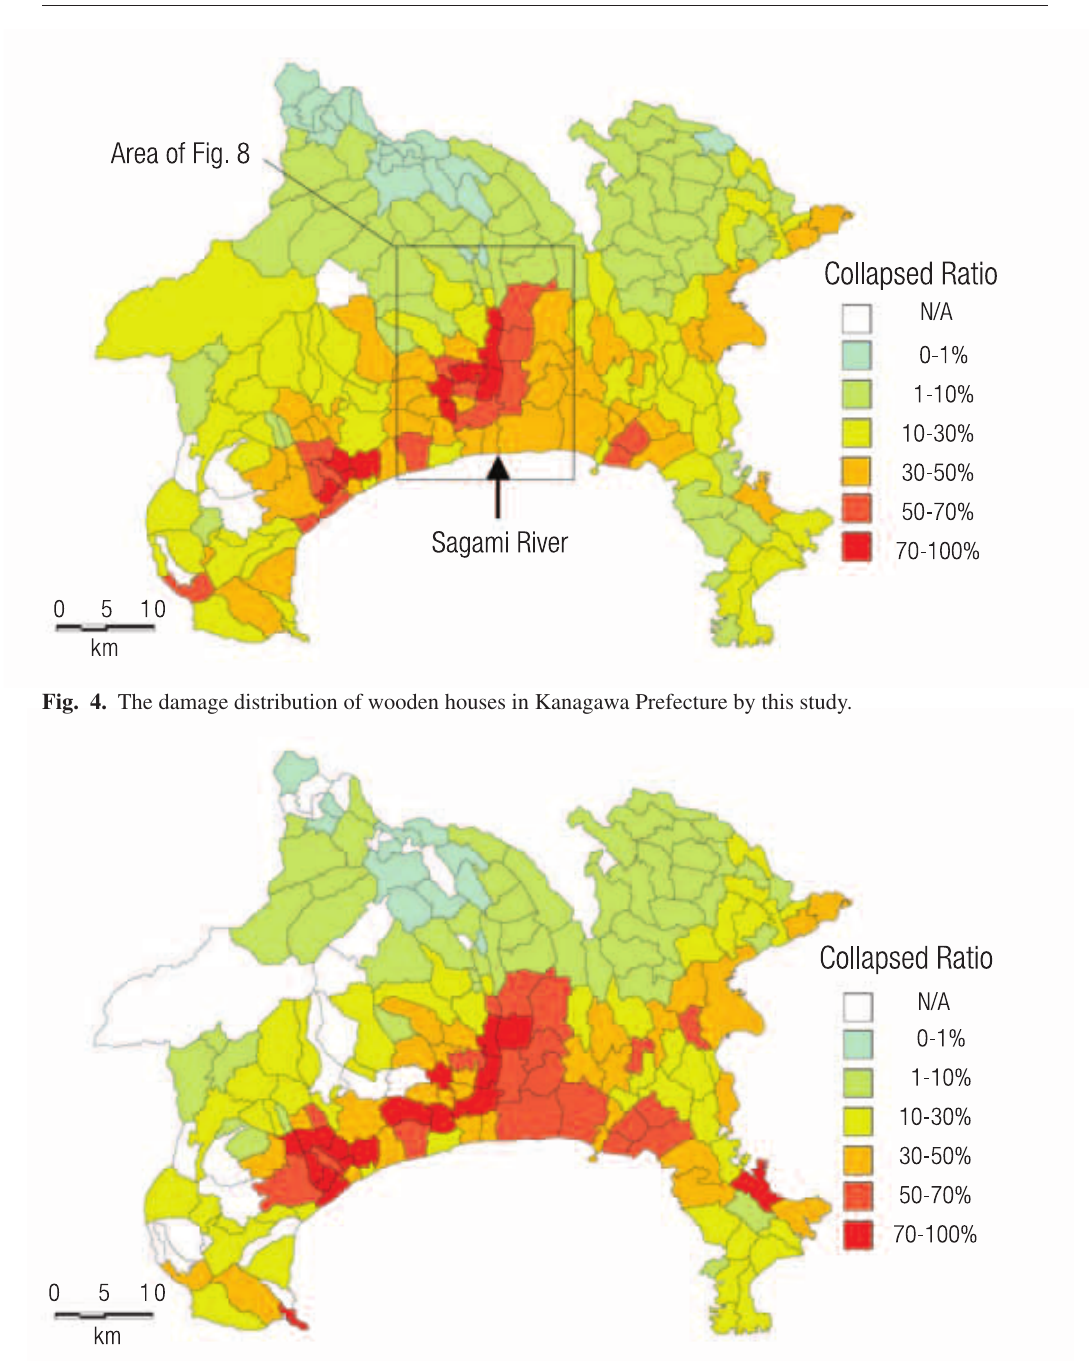
Fig. 5. The damage distribution of wooden houses in Kanagawa Prefecture by Matsuzawa